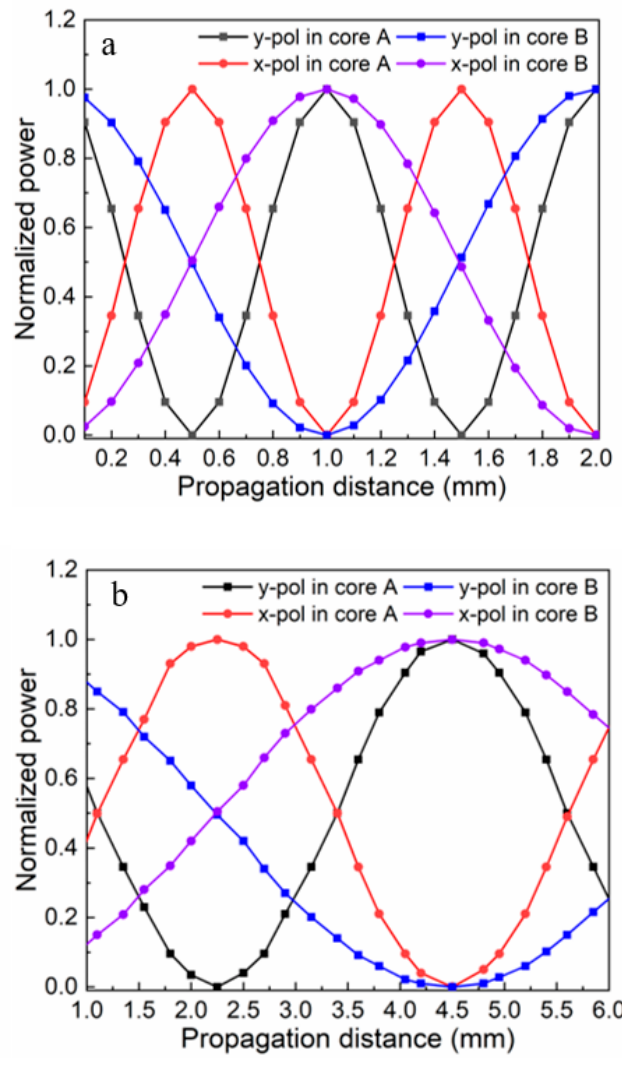
Figure 4. Various energy transfer values in cores A and B for the proposed PCF-PBS ( a ) with the As 2 S 3 layer and ( b ) without the As 2 S 3 layer versus the propagation distance when Λ = 2.2 µ m, d 1 = 1.1 µ m, d 2 = 2.2 µ m, and t = 150 nm.